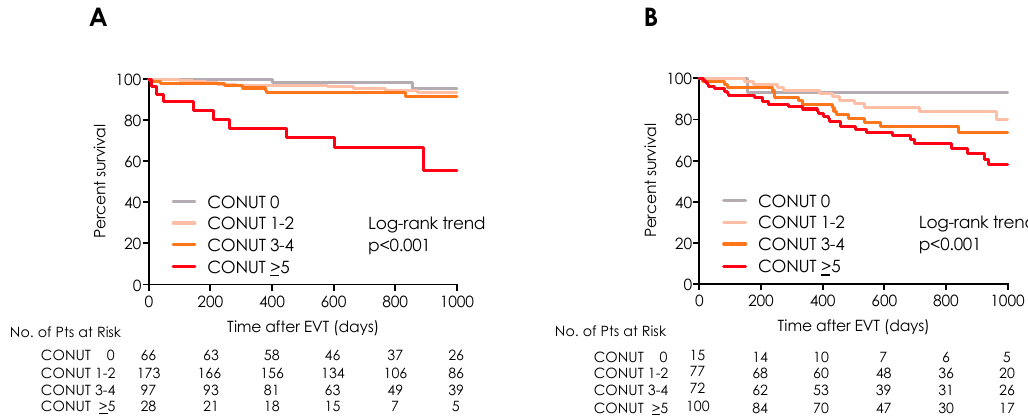
Figure 3. All-cause mortality after endovascular therapy in patients with and without chronic limb ischemia (CLI). Kaplan–Meier curves of the all-cause mortality rates for the four subgroups categorized according to the Controlling Nutritional Status score on admission in ( A ) Non-CLI patients and (B) CLI patients. CLI = critical limb ischemia; CONUT = Controlling Nutritional Status score; EVT = endovascular therapy.